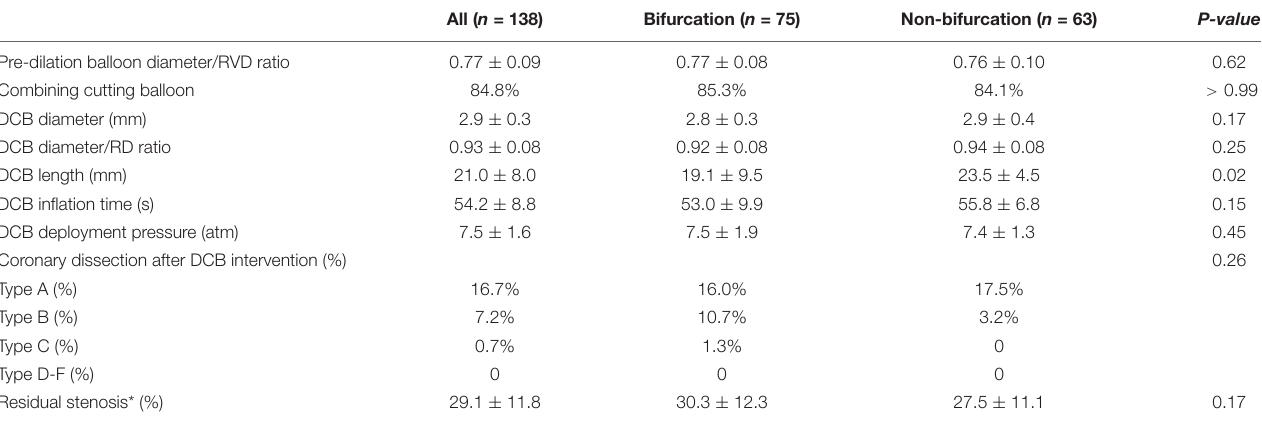
TABLE 3 | Procedural